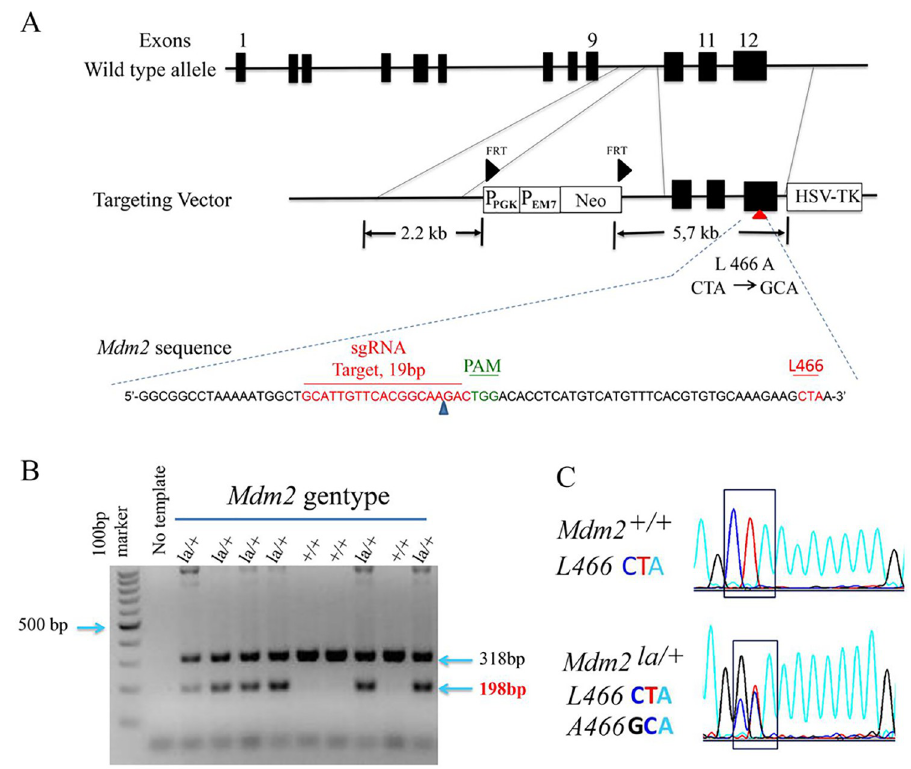
Fig 2. Generation of Mdm2 L466A allele. ( A ) A diagram depicting the strategy for creating the Mdm2 L466A mutant allele is shown. A conventional targeting vector, sgRNA (in green) and anti-sense template DNA sequences including Mdm2 L466A mutations are shown. ( B ) Genotyping results of wild type Mdm2 and Mdm2 L466A alleles by PCR and DNA sequencing using tail DNA from mouse pups. The wild-type Mdm2 amplicon (318bp), the Mdm2 L466A amplicon (198bp). ( C ) The nucleotide changes for codon L466 in DNA sequencing chromatograms are shown.